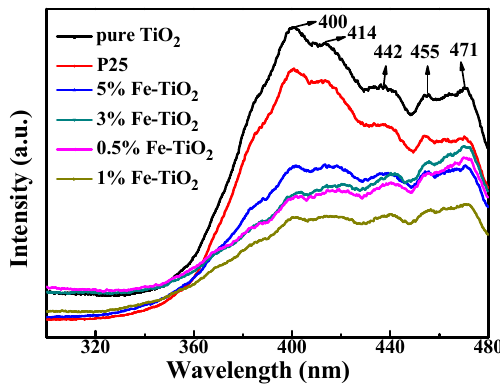
Figure 11. Photoluminescence ( PL) spectra of different catalysts excited by UV light of 254 nm.